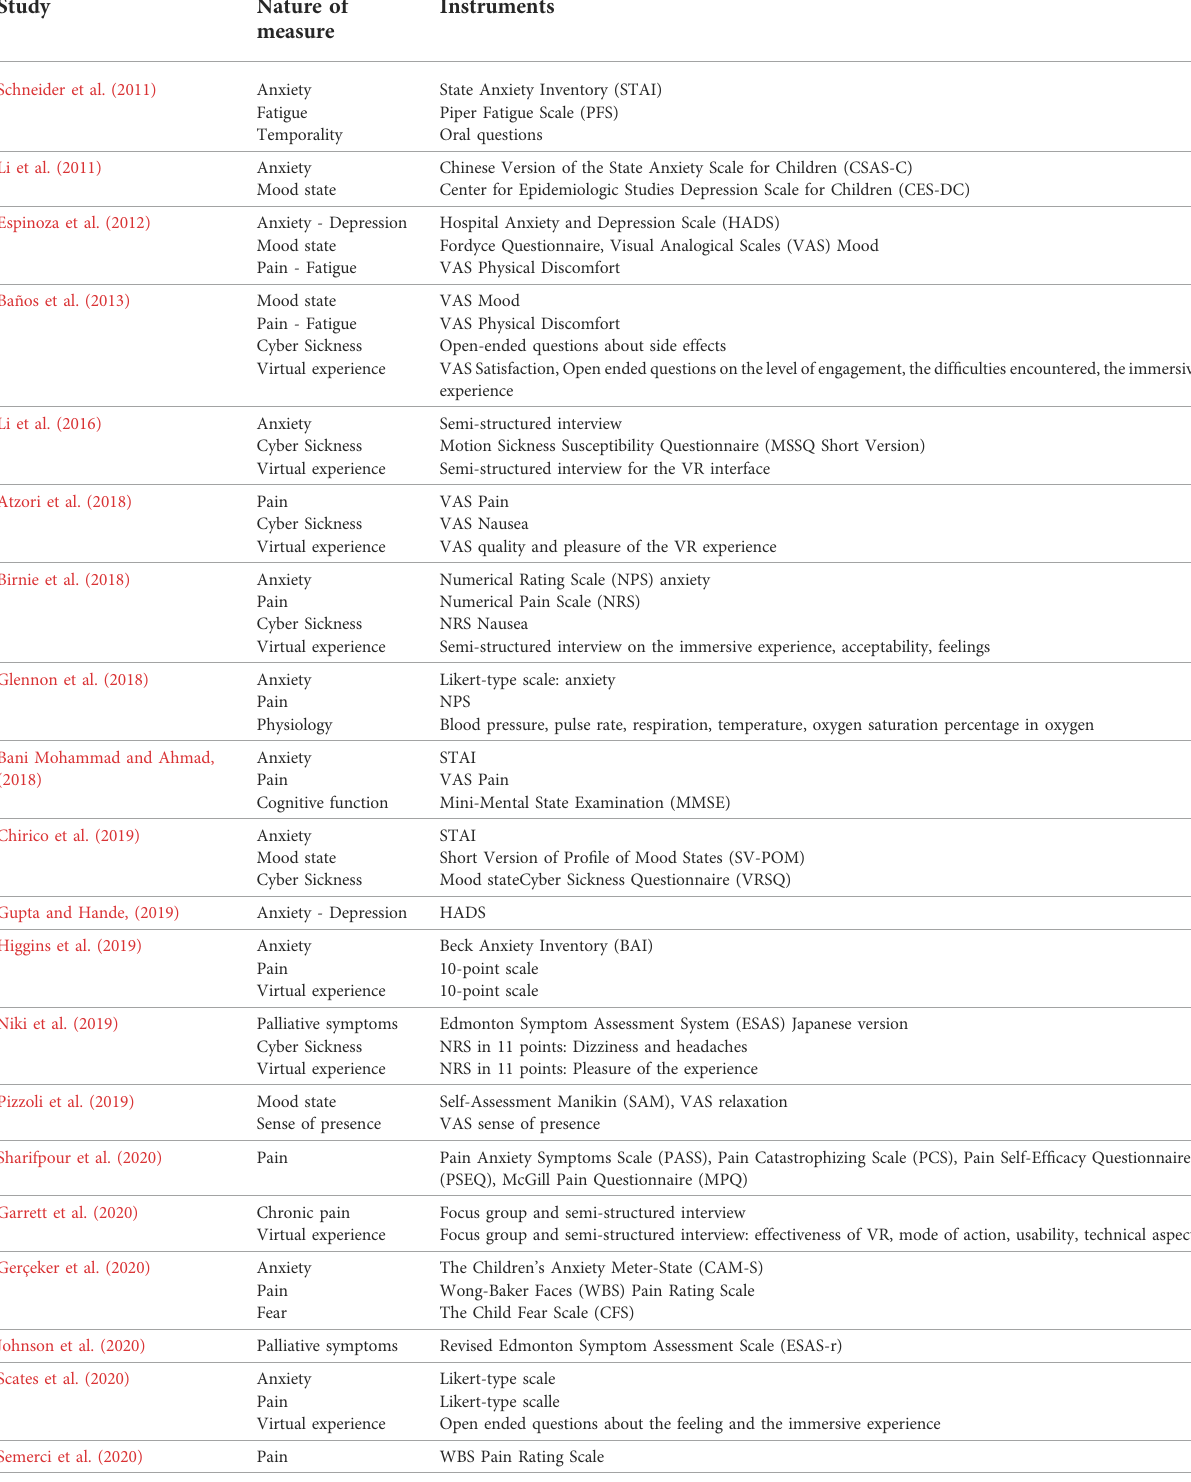
TABLE 2 Nature of measure and instruments in studies evaluating the effects of virtual reality in